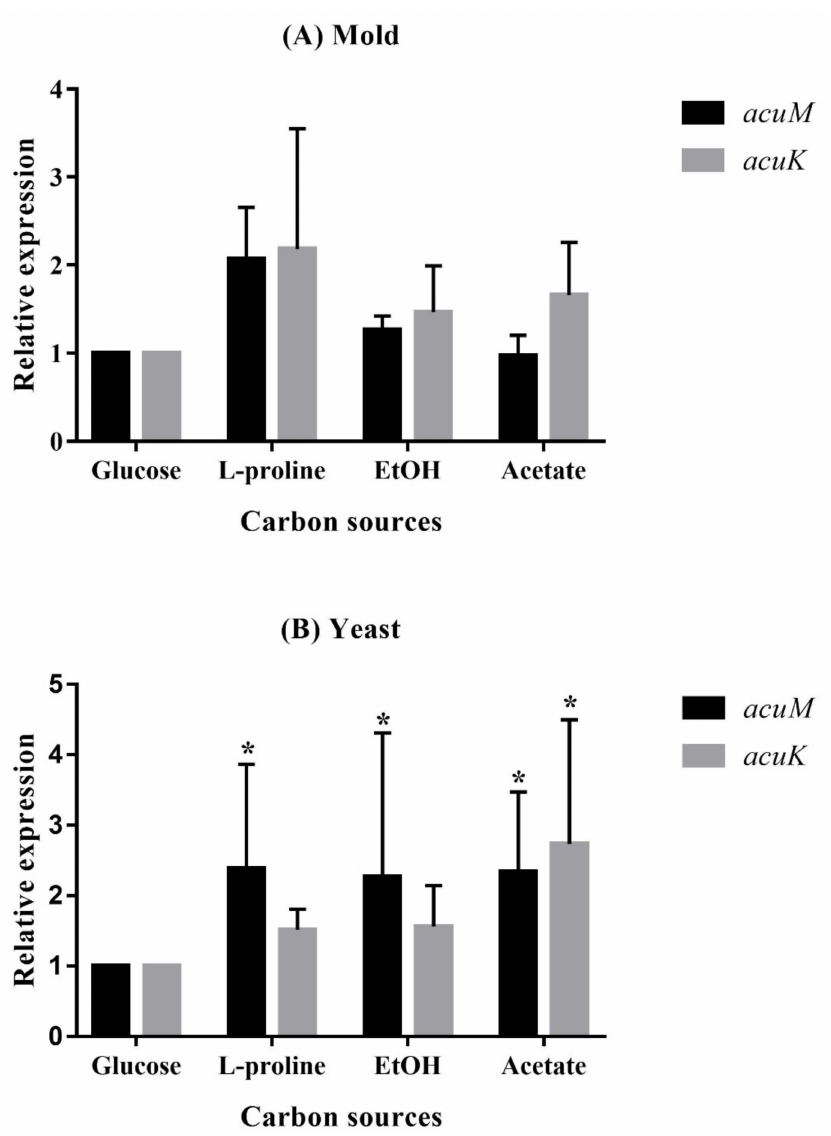
Figure 5. Relative expression levels of acuM and acuK during growth in gluconeogenic carbon sources. T. marne ff ei was cultured in the carbon-free medium containing one of the designated carbon sources, 1.0% glucose, 50 mM proline, 0.5% ethanol, or 50 mM acetate, for 36 h at 25 ◦ C for the mold phase ( A ) and for 60 h at 37 ◦ C for the yeast phase ( B ). The bars show average values and standard deviations from three independent experiments. An asterisk indicates a significant di ff erence ( p < 0.05) when compared to the respective gene in glucose